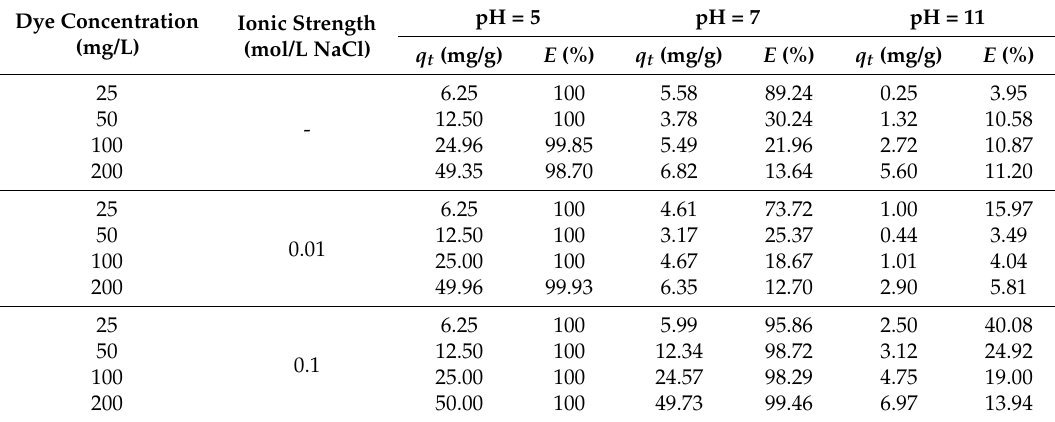
Table 1. Influence of pH and ionic strength on sodium copper chlorophyllin (SCC) adsorption capacity on H. communis spongin-based skeleton (contact time 60